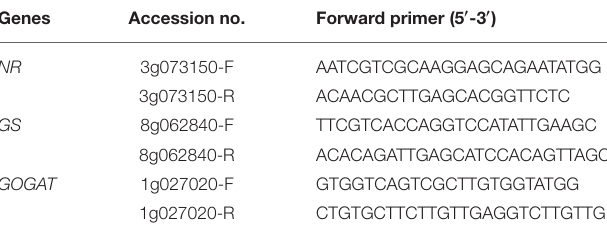
TABLE 1 | Sequences of the primers used for polymerase chain